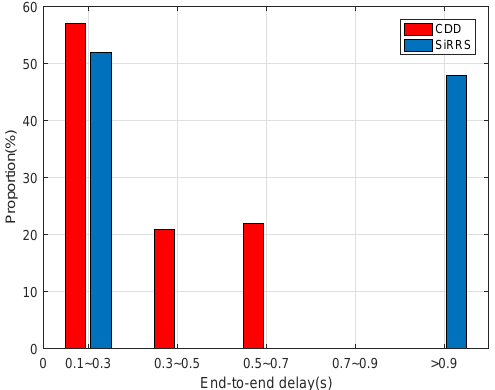
Figure 13. Distribution of delay of light data load.